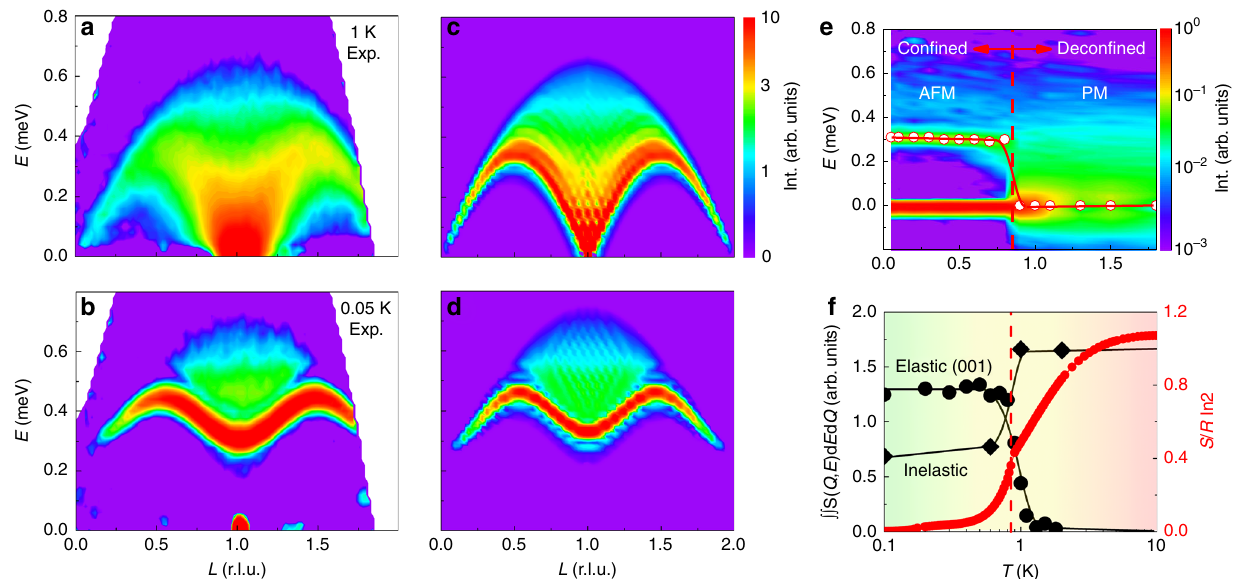
Fig. 3 Spinon con fi nement of YbAlO 3 in zero fi eld. Inelastic neutron scattering spectra with background corrected measured at 1 K ( a ) and 0.05 K ( b ), compared to DMRG calculation with B st / J = 0 ( c ), and B st / J = 0.27 ( d ). The DMRG calculation is performed on a 64-site periodic chain with bond dimension M = 400 states at T = 0, with intrachain interaction J = 0.21 meV. In d , the elastic peak at L = 1 has been removed by hand. e Temperature evolution of the energy-dependent neutron scattering spectrum integrated in window H = [ − 0.1, 0.1] r.l.u., K = [ − 0.1, 0.1] r.l.u., L = [0.9, 1.1] r.l.u. A gapless continuum is observed at high temperatures, whereas a gap of about 0.3 meV (red circles) opens just at T N , due to the appearance of the staggered fi eld. f Temperature dependence of the elastic (001) magnetic peak intensity (black circles) and inelastic neutron spectrum (black diamonds) integrated in the window H = [ − 0.1, 0.1] r.l.u., K = [ − 0.1, 0.1] r.l.u., L = [0, 2.0] r.l.u., and E = [0.1, 0.6] meV. The elastic and inelastic scatterings correspond to the statically ordered and fl uctuating magnetic moments, respectively. The red circles are the temperature-dependent entropy ( S ). The solid lines are a guide to the eyes, and the vertical red dashed line indicates the spinon con fi nement – decon fi nement transition at T